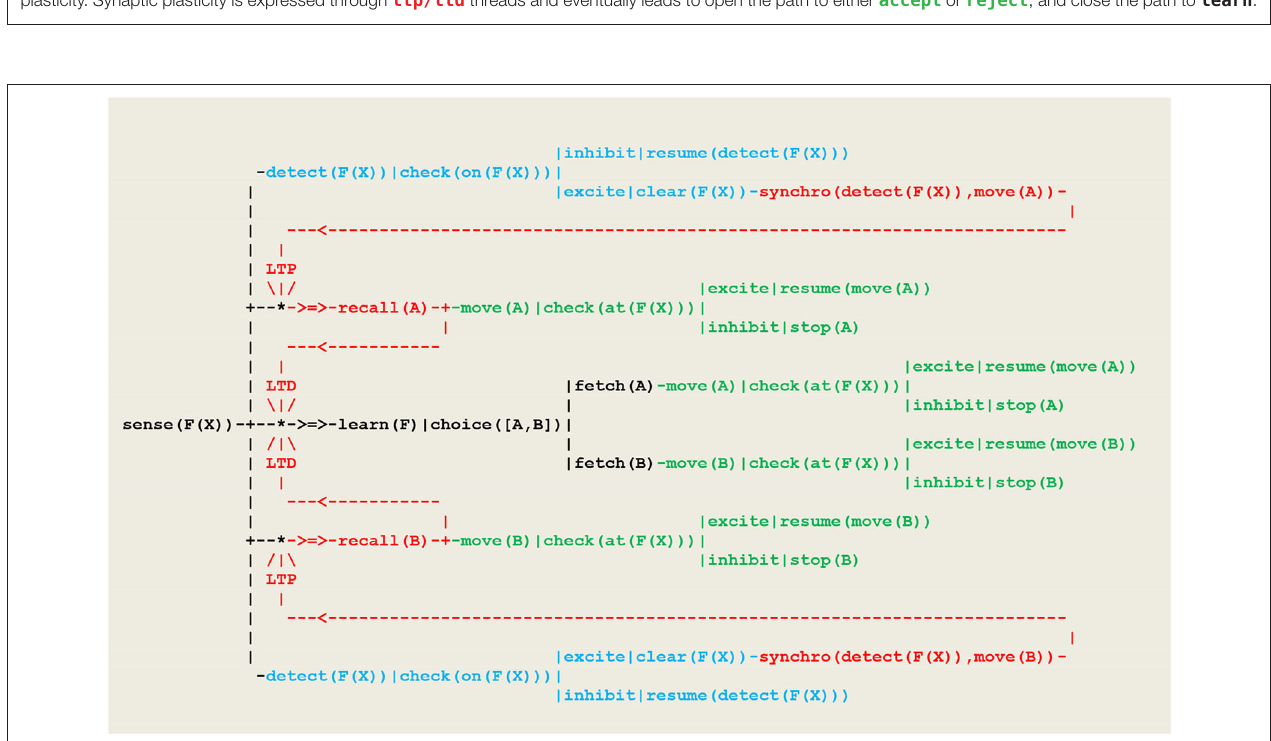
FIGURE 12 | Neural circuit implementing a simple form operant conditioning. At the beginning, the pathway from sense to learn is open, while the pathways to accept and reject are closed. The learn thread discriminates between positive and negative external stimuli, and thus functions as a fork directing synaptic plasticity. Synaptic plasticity is expressed through ltp/ltd threads and eventually leads to open the path to either accept or reject , and close the path to learn .